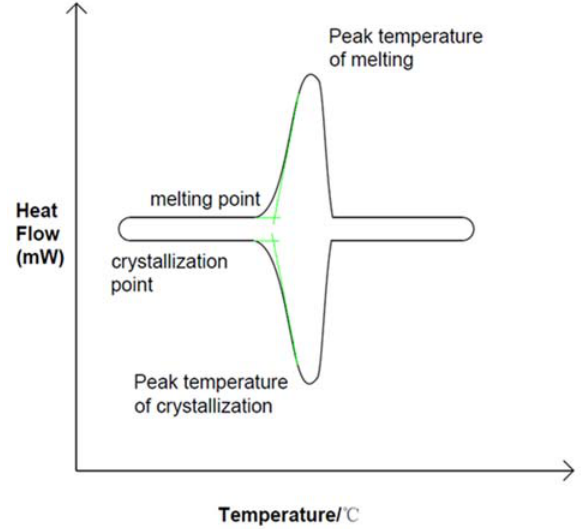
Figure 1. DSC curve of ideal phase transition, Reprinted with permission from ref. [10].